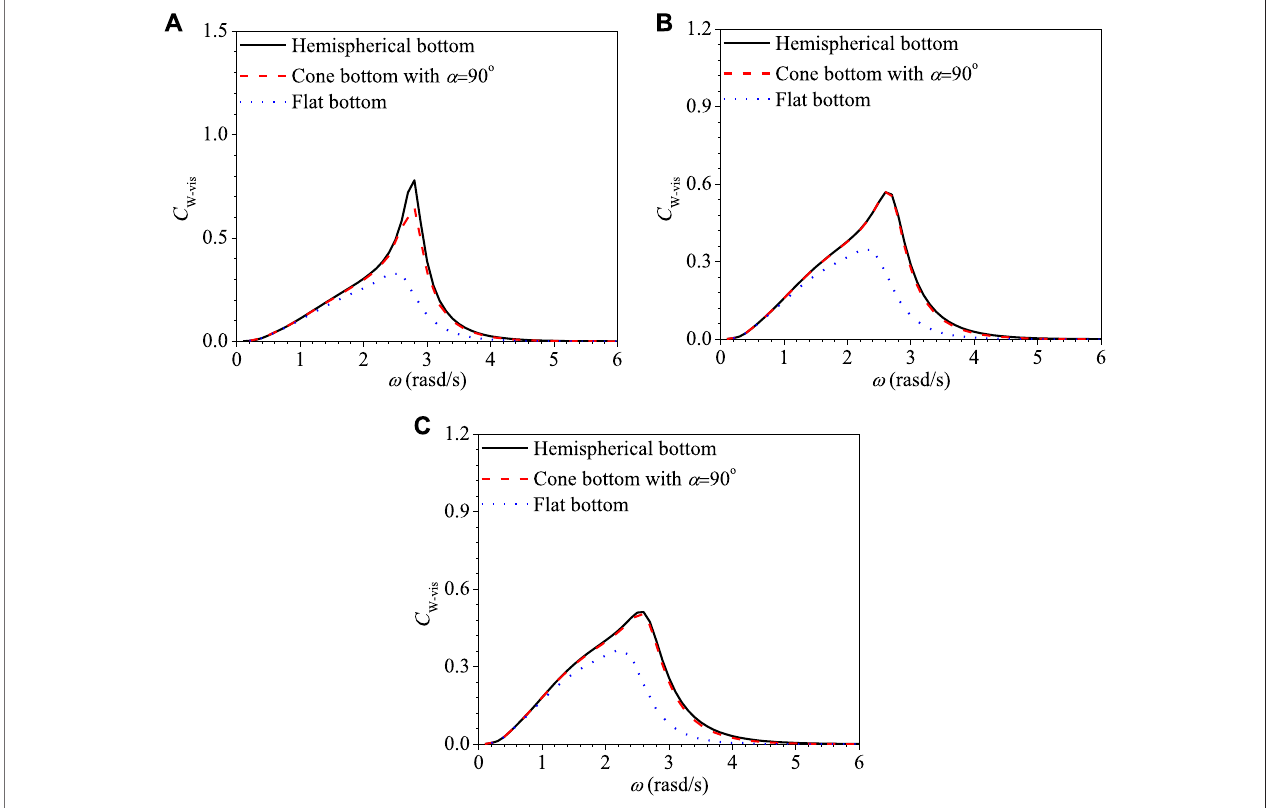
Figure 9 | Variations of CWR C w versus ω with different bottom shapes based on PFT with viscous correction. (A) 2 r / d (cid:2) 1.6. (B) 2 r / d (cid:2) 2.4. (C) 2 r / d (cid:2) 2.8.